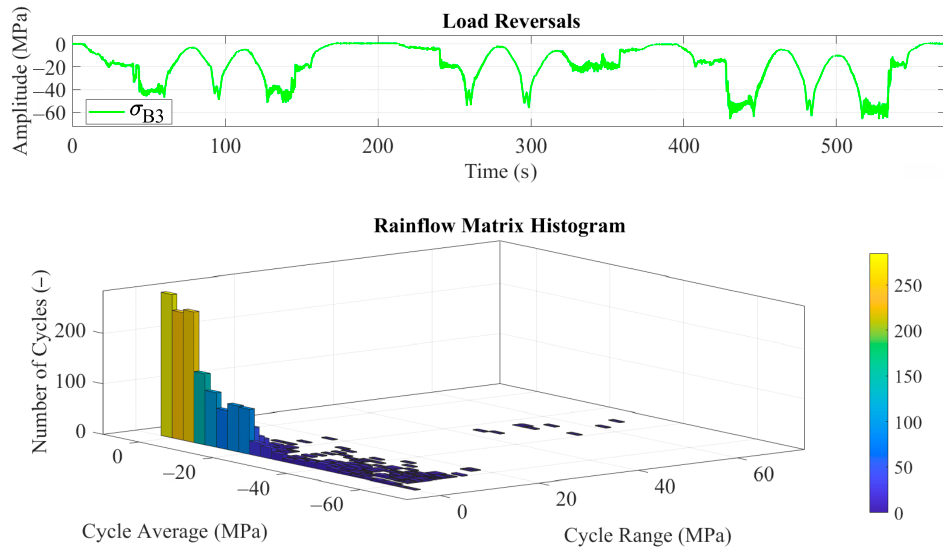
Figure 10. Spectrum of stress amplitudes, Mode 2.